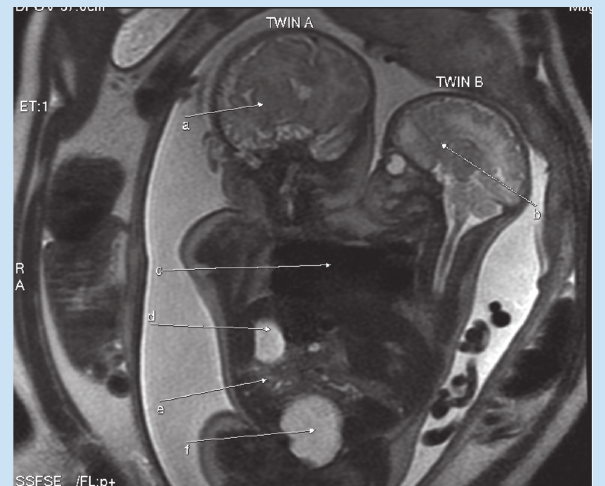
Fig.1. Coronal T2-weighted MRI. a: brain of twin A demonstrating mature grey-white matter differentiation b: twin B on the right in a sagital position looking at twin A c: the complex multi-chambered heart d: stomach of twin A e: horseshoe kidney f: high signal in the pelvis due to a single full bladder.